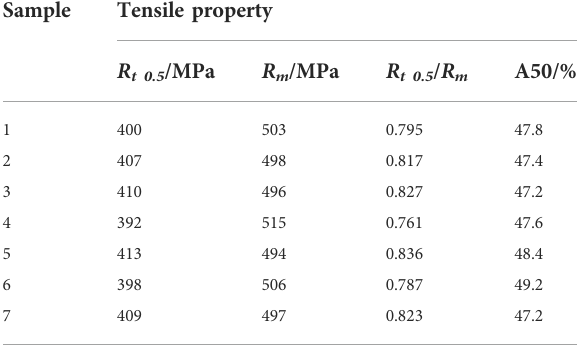
TABLE 3 Tensile properties of seven standard static tensile